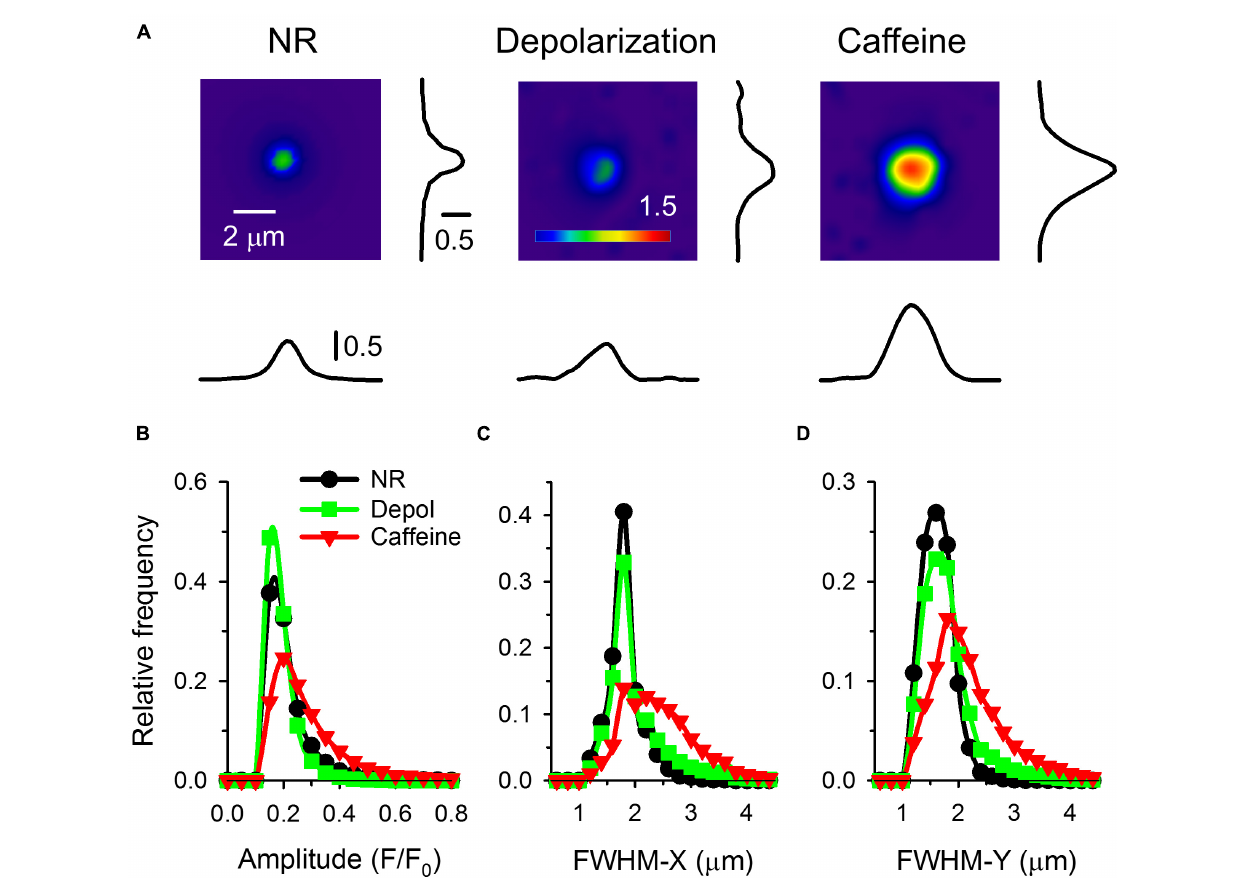
FIGURE 4 | (A) Individual sparks on a larger scale. All images were recorded with 30 FPS. Next to the spark the spatial profile of F/F 0 in X & Y direction (parallel and perpendicular to fiber axis) are presented. Panels (B–D) present the distribution histograms for the amplitude (B) , FWHM-X (C) , and FWHM-Y (D) under control conditions (black circles), on fibers depolarized to a calculated value of -65 mV (green squares), and in the presence of 1 mM caffeine (red triangles). Note how both depolarization and caffeine has shifted the distribution the higher values, especially visible in case of FWHM-X and FWHM-Y in the presence of caffeine from 2.5 µ m to 4 µ